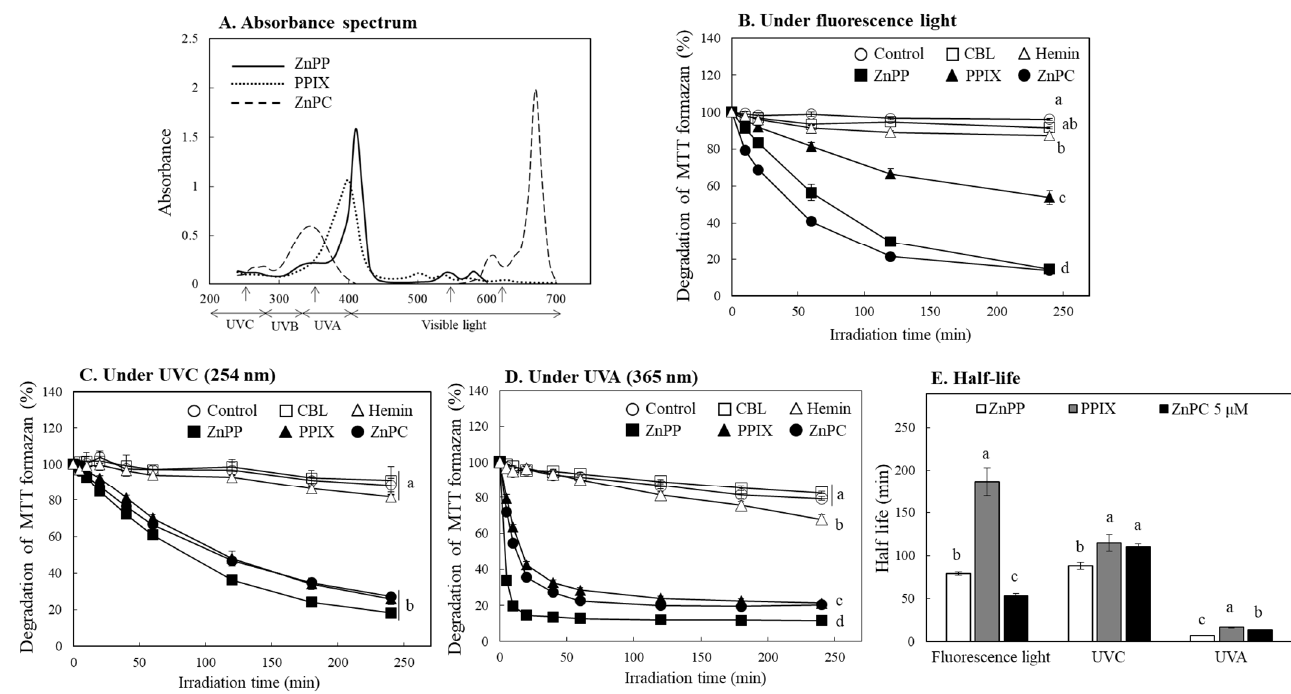
Figure 7. Effects of porphyrins on degradation of MTT formazan under different light conditions. Absorbance spectrum of ZnPP, PPIX, and ZnPC dissolved in DMSO (10 µ M) was analyzed ( A ) (The upward arrows in A indicate the emission peaks of the light source used). MTT formazan formed was irradiated with different porphyrins under a fluorescent light ( B ), UVC (254 nm) ( C ) or UVA (365 nm) ( D ) during 4 h. Time-dependent changes in color response of MTT formazan in the presence of each compound (5 µ M) were analyzed using a microplate reader at 550 nm. Half-lives of formazan color degradation by each porphyrin under different lights were also calculated ( E ). Each value represents the mean ± S.D. ( n = 3). Different letters indicate a significant difference among different light treatments ( p < 0.05) based on one way ANOVA and the Tukey’s HSD test.